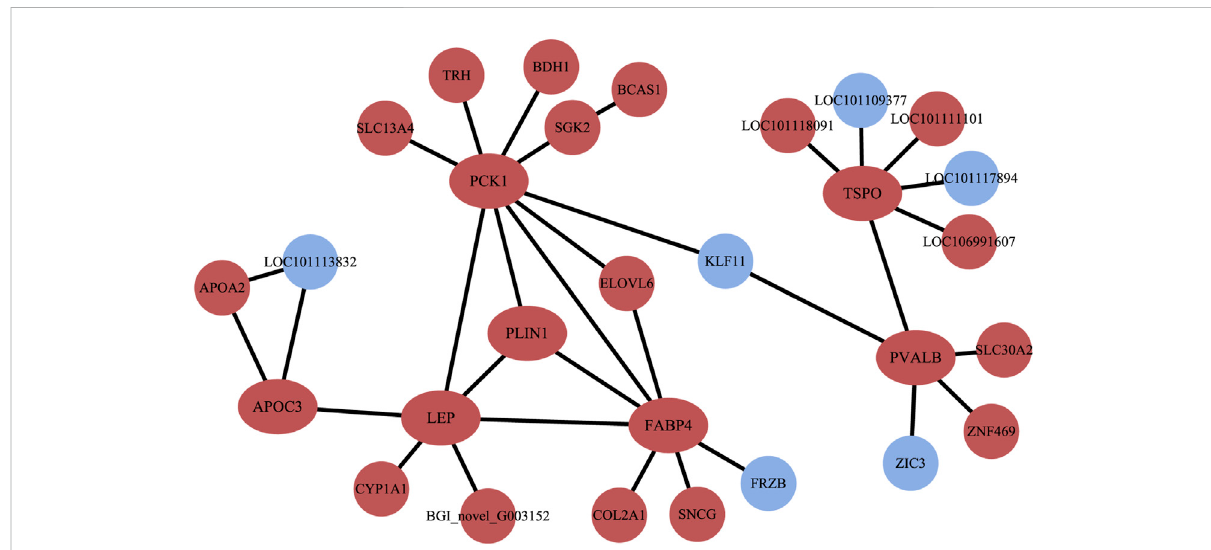
FIGURE 5 The interaction of protein coded by differentially expressed genes (DEGs). The red circles and ellipses represent up-regulated genes, while the wather blue circles represent down-regulated